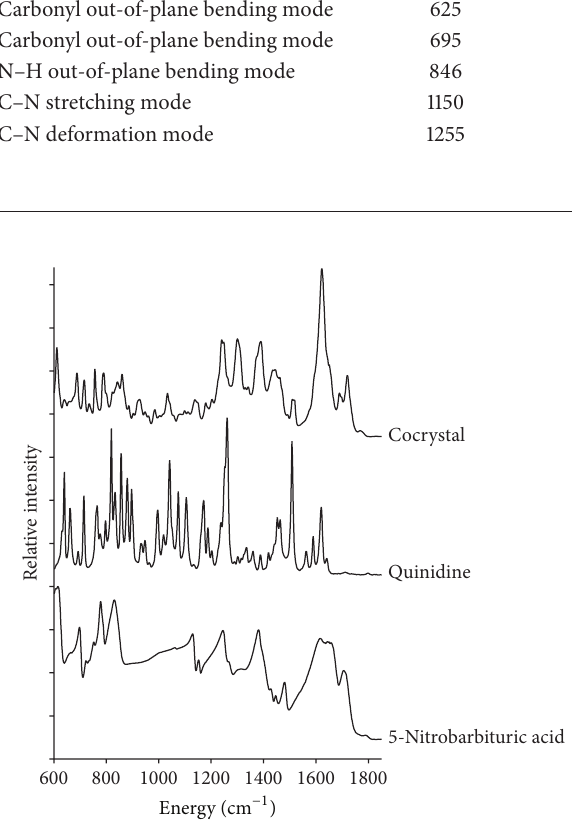
Figure 12: X-ray powder diffraction patterns of 5-nitrobarbituric acid, quinidine, and the 1: 1 nitrobarbituric-quinidine